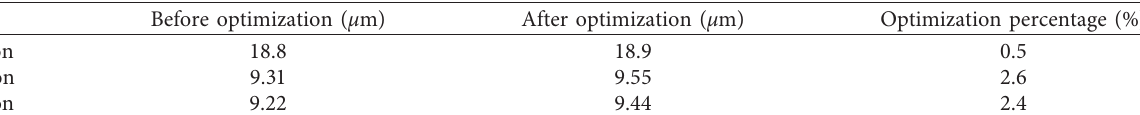
Table 3: Amplitudes before and after optimization.